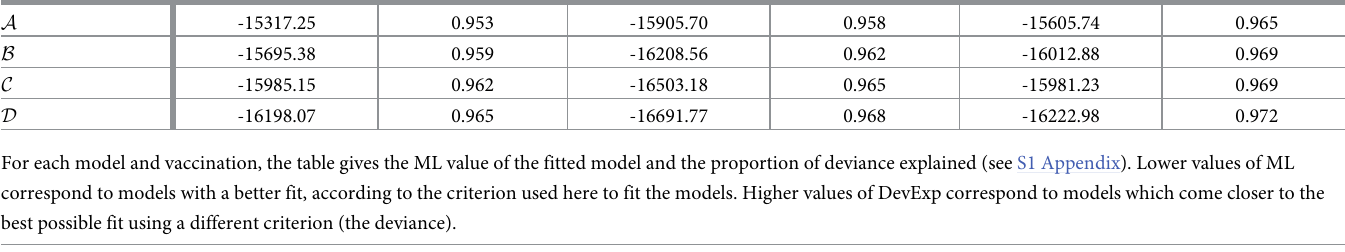
Table 1. ML values and proportion of deviance explained.